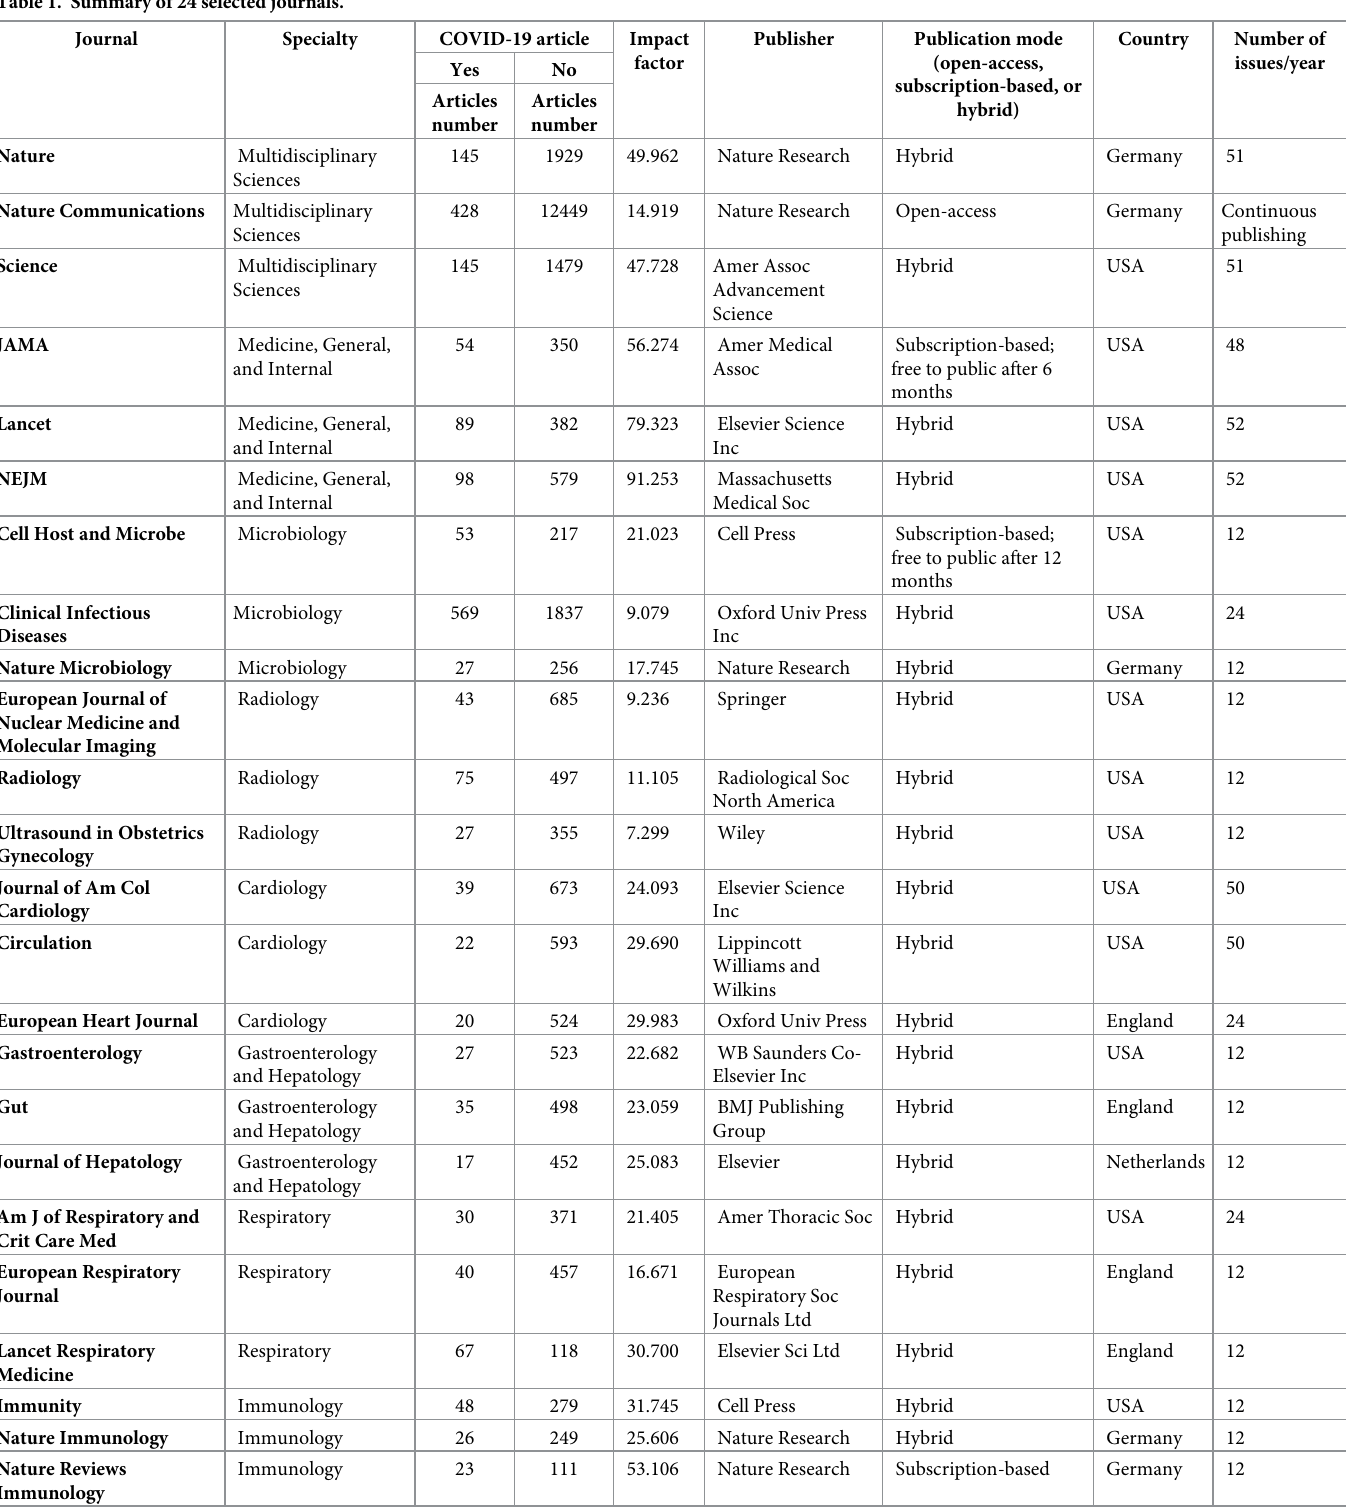
Table 1. Summary of 24 selected